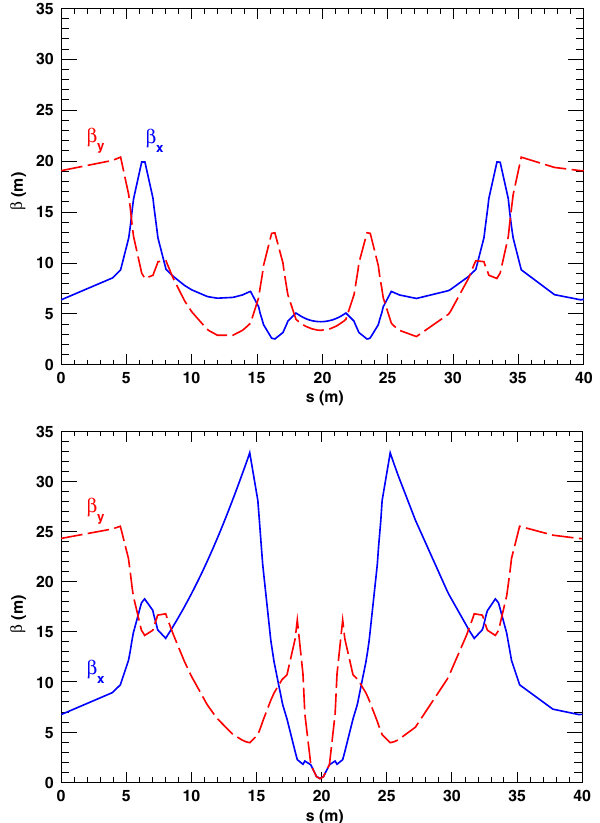
FIG. 5. Model calculation of the β -functions for the standard COSY setting ( D ≠ 0 ) with PAX magnets switched OFF (top panel) and ON (bottom panel), indicating that minimal ≈ 0 . 3 m can be reached at the target point at values of β x;y s ¼ 19 . 87 m. s ¼ 0 is located at the beginning of the target straight